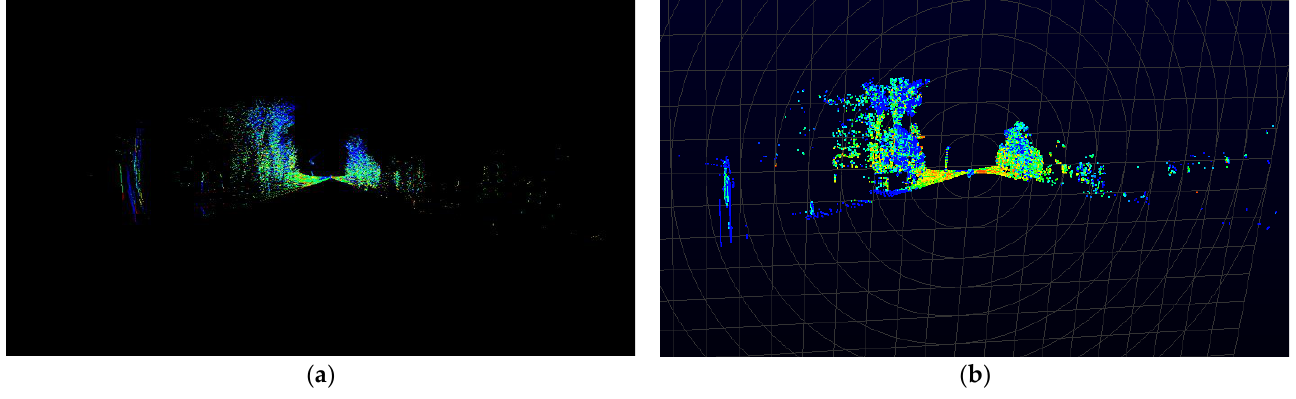
Figure 16. Point cloud comparison: ( a ) point cloud image of this paper, ( b ) ideal point cloud.